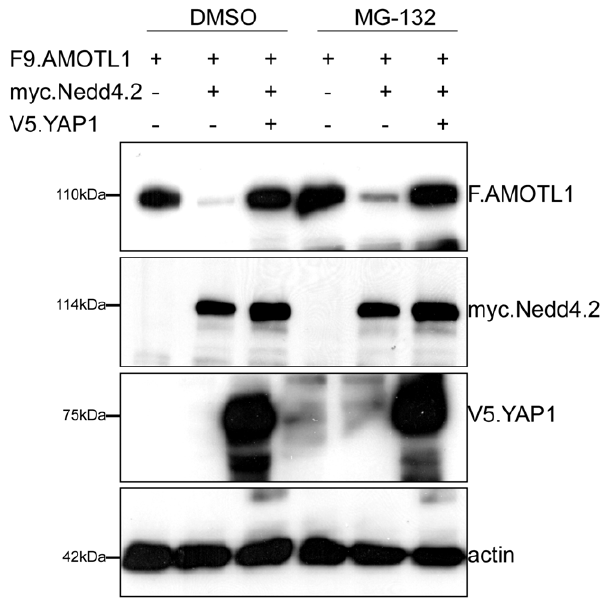
Figure 3. Nedd4.2 targets AMOTL1 for proteasomal degrada- tion. HEK 293T cells were transfected with AMOTL1, Nedd4.2 and YAP1, as indicated. Cells were treated with 5 m M MG132 for 120 min. Lysates were analyzed by Western blotting. AMOTL1, Nedd4.2 and YAP1 were detected with anti-Flag, anti-myc and anti-V5 antibodies, respectively. Actin was used as a loading